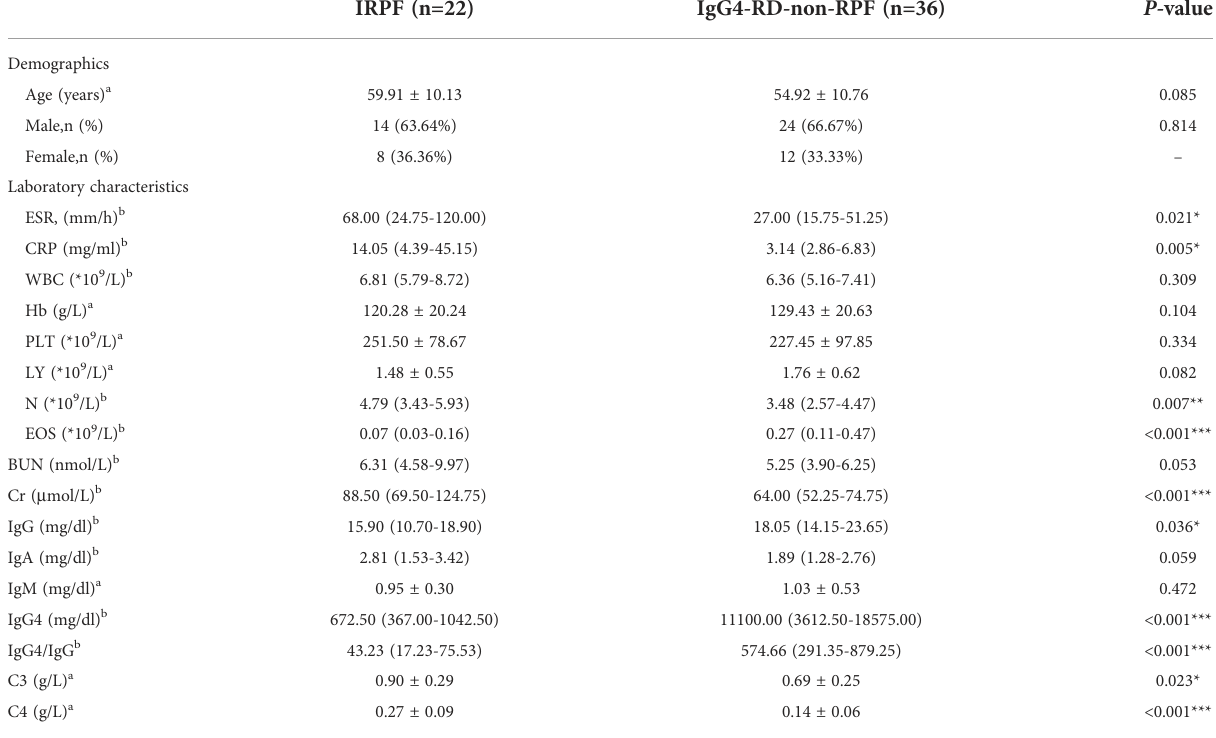
TABLE 2 Characteristics and laboratory data of IRPF group and IgG4-RD-non-RPF